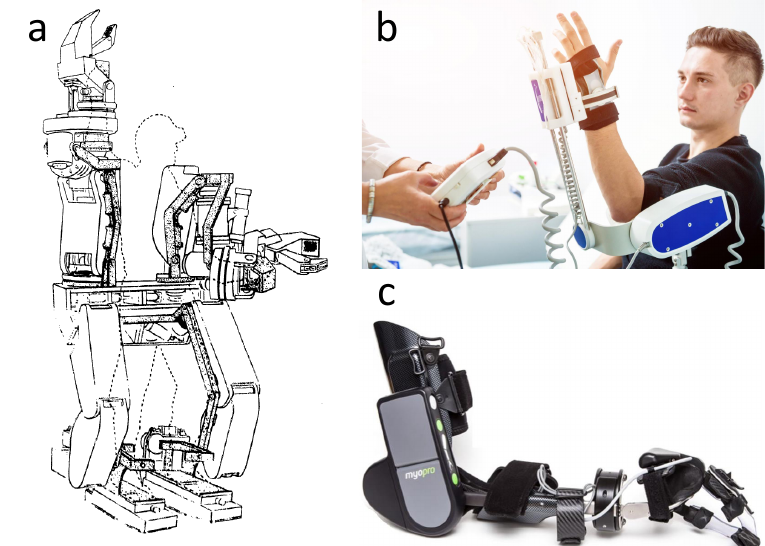
Figure 1. Examples of bionic orthosis solutions: ( a ) Hardiman (figure by Bruce Fick and John Makinson), ( b ) Myopro (reproduced with permission from [28], Myomo, 2020), ( c ) Patient on continuous passive range of motion machine (figure from